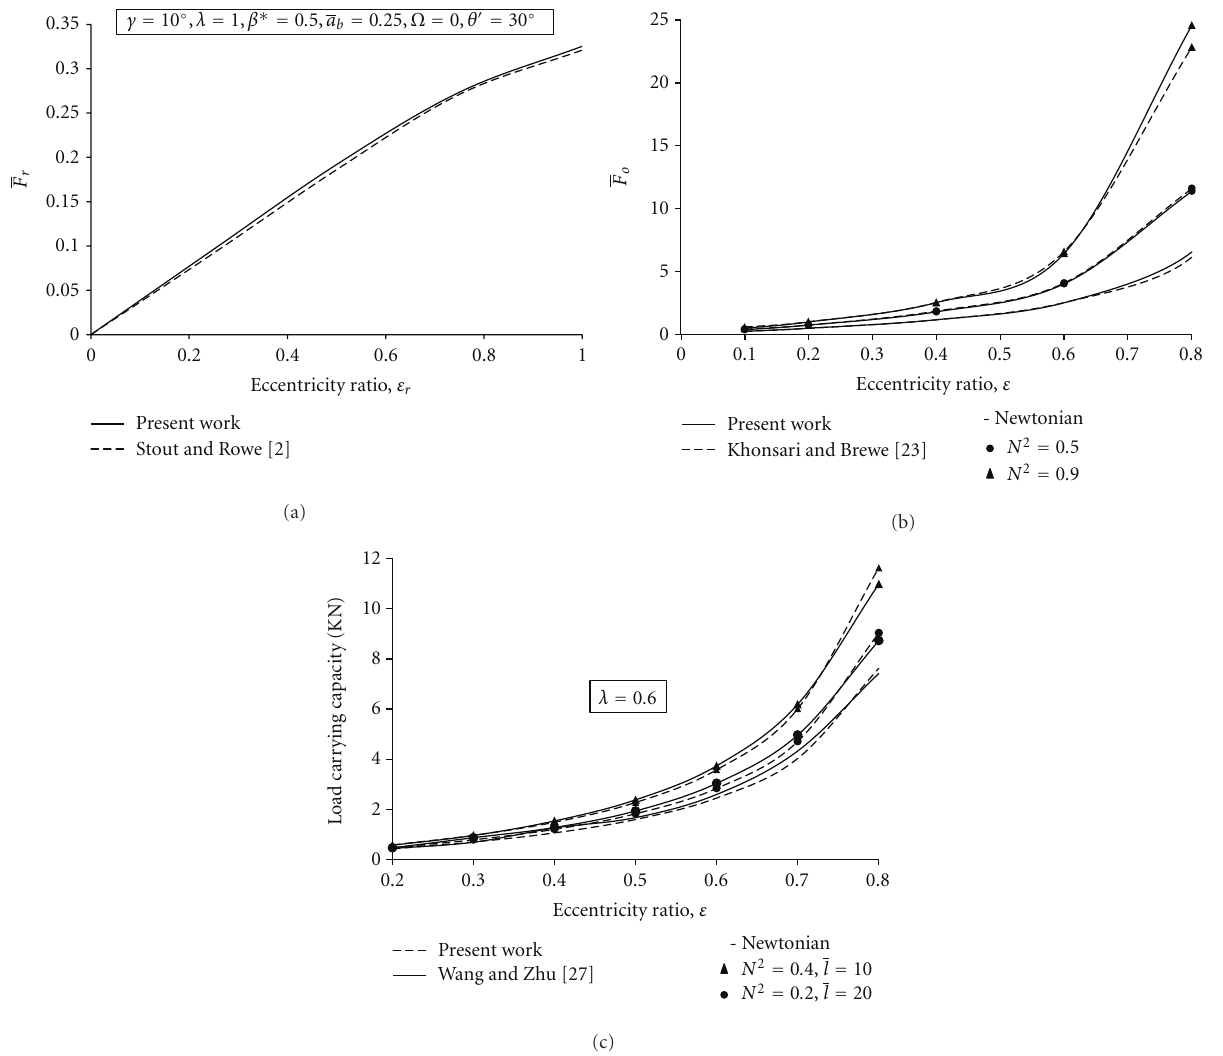
Figure 4: (a) Radial load carrying capacity ( F r ) versus eccentricity ratio ( ε r ). (b) Load carrying capacity ( F o ) versus eccentricity ratio ( ε ). (c) Load carrying capacity ( F o ) versus eccentricity ratio ( ε